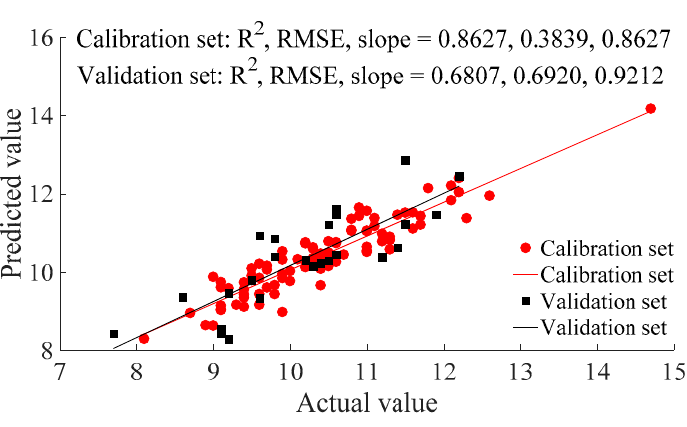
Figure 5. PLSR detection results of TSS based on 736 features of Savitzky-Golay processed